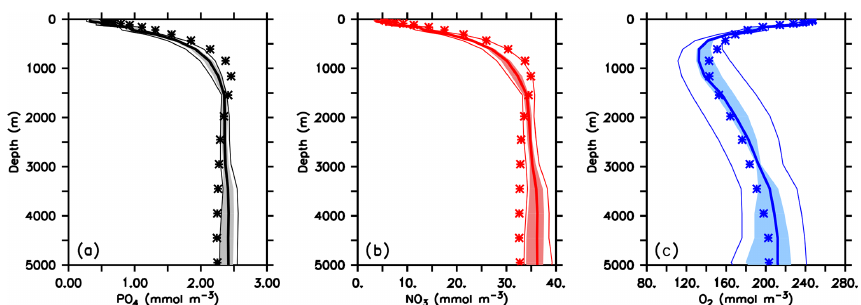
Figure 4. Global mean vertical profiles of phosphate (a) , nitrate (b) and oxygen (c) . Thin lines denote range across all 25 model experiments, shaded areas the range across the five optimal model experiments and the thick lines the average of optimal model experiments. Stars denote observed profiles. Prior to averaging, all models have been regridded onto the ECCO grid, using nearest-neighbour filling in the vertical and linear interpolation